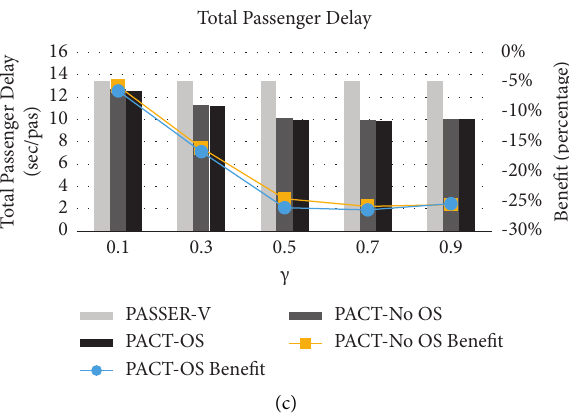
Figure 14: Delay changes in (a) auto passenger, (b) bus passenger, and (c) total passenger under various signal adjustable parameters.